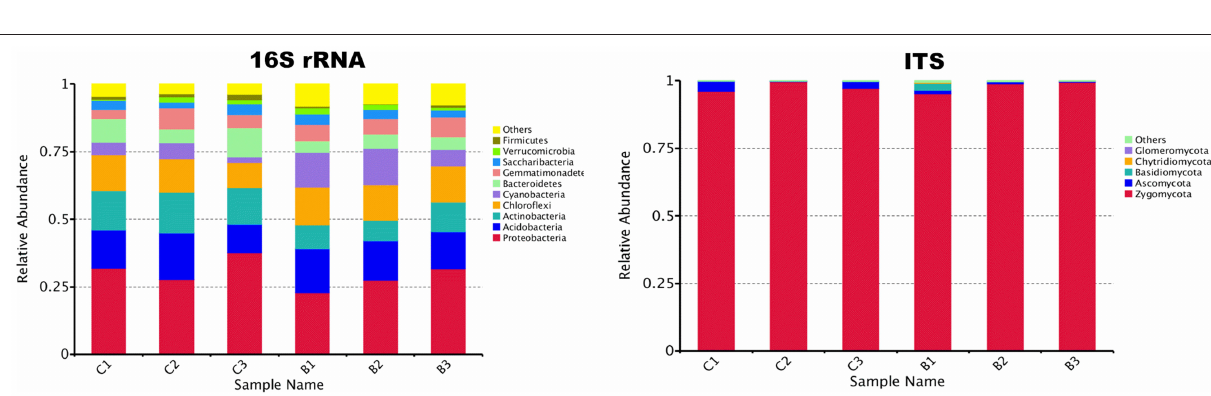
(97.59%), Ascomycota (2.26%), Basidiomycota (0.05%), Chytridiomycota (0%), Glomoromycota (0.004%), and others (0.08%) and in intercrop Zygomycota (97.83%), Ascomycota (0.83%), Basidiomycota (0.88%), Chytridiomycota (0.11%), Glomoromycota (0.014%), and others (0.31%) ( Figure 3 ).